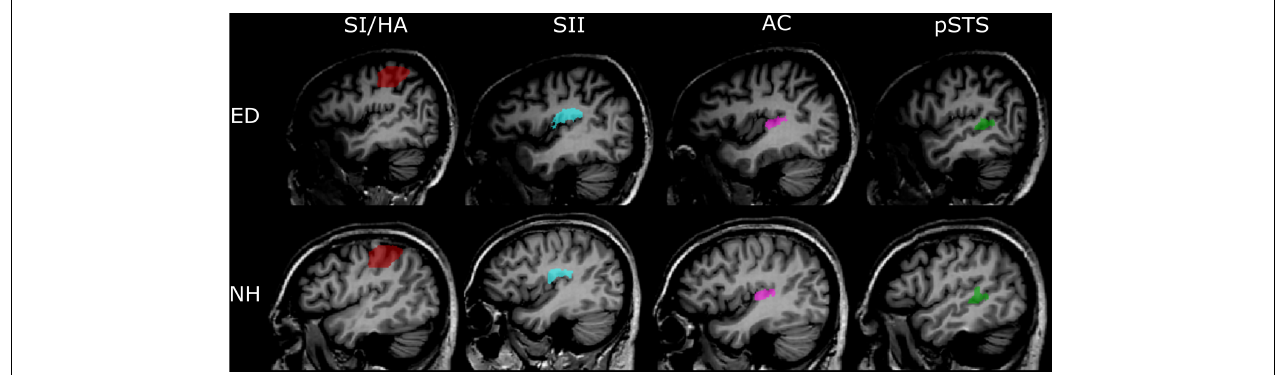
FIGURE 2 | Representative anatomically and functionally defined ROIs. Sagittal views of the four ROIs in the left hemisphere defined using either the functional (pSTS) or anatomical (SI/HA, SII, PAC) criteria are shown in the Talairach volume space of a representative ED (top panel) and NH participant (bottom panel). Red, SI/HA; light blue, SII; pink, PAC; green, functionally defined pSTS.